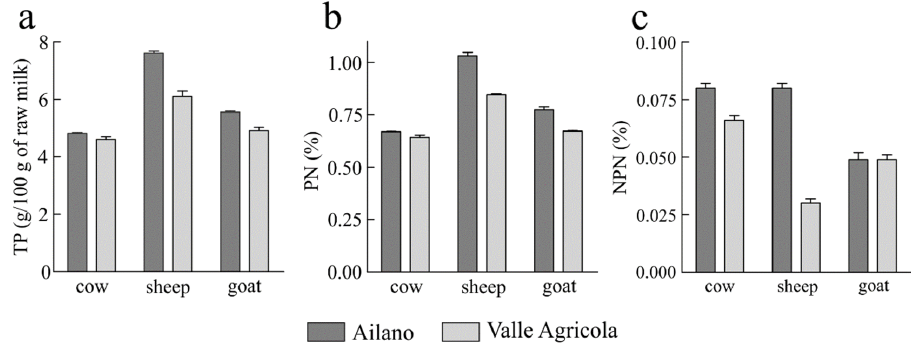
Figure 2. ( a ) Total protein content (TP), ( b ) protein nitrogen (PN) and ( c ) non-protein nitrogen (NPN) content of cow, goat and sheep milk from ‘Ailano’ and ‘Valle Agricola’ territories. 3.2. Amino Acid Content of Cow Raw Milk from ‘Ailano’ and ‘Valle Agricola’